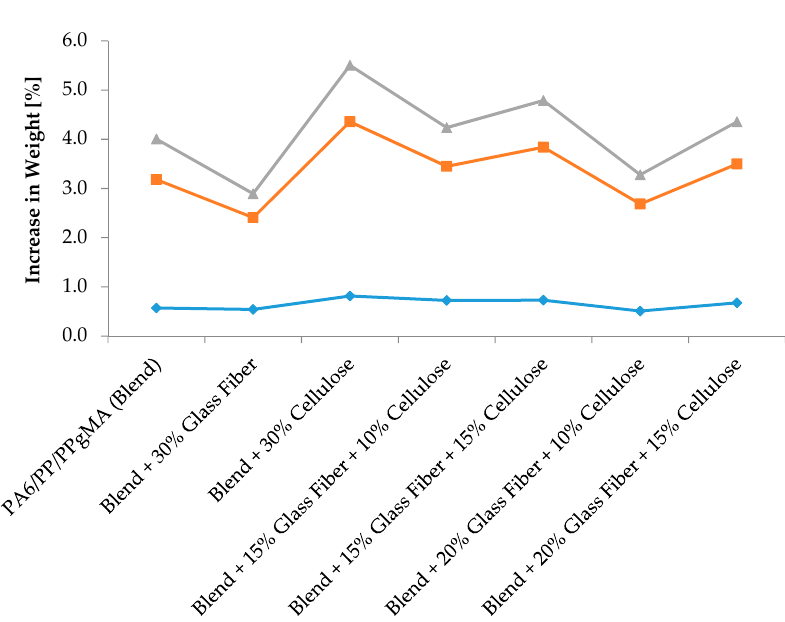
Figure 4. Water absorption of unfilled polymer blends and cellulose and glass fiber reinforced composites.